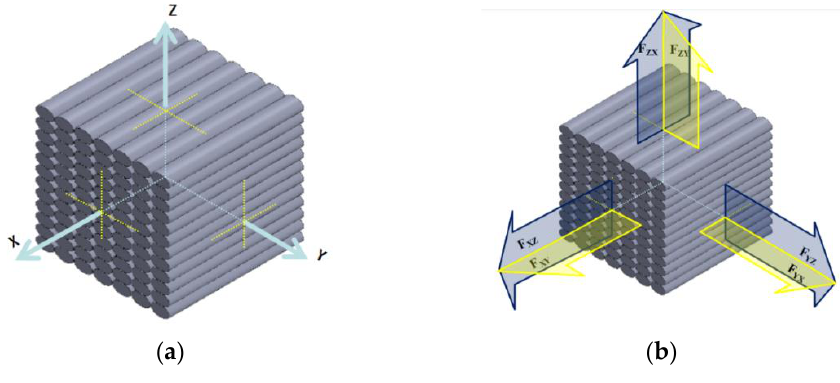
Figure 2. ( a ) Coordinate system, ( b ) loading direction.